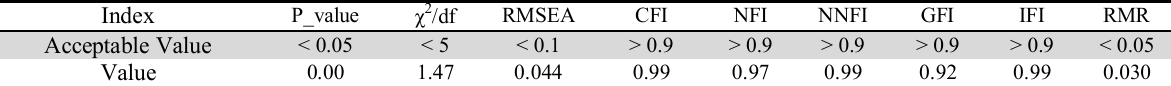
Fit indexes of model